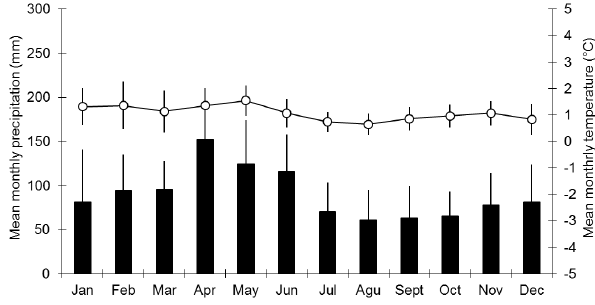
Fig. 2. Mean monthly precipitation (bars) and temperatures (dots) over 1yr at the Antisana volcano, Ecuador. The weather station is located on the proglacier margin of Glacier 15 at 4850m. Mean val- ues and standard deviations were calculated over 6yr